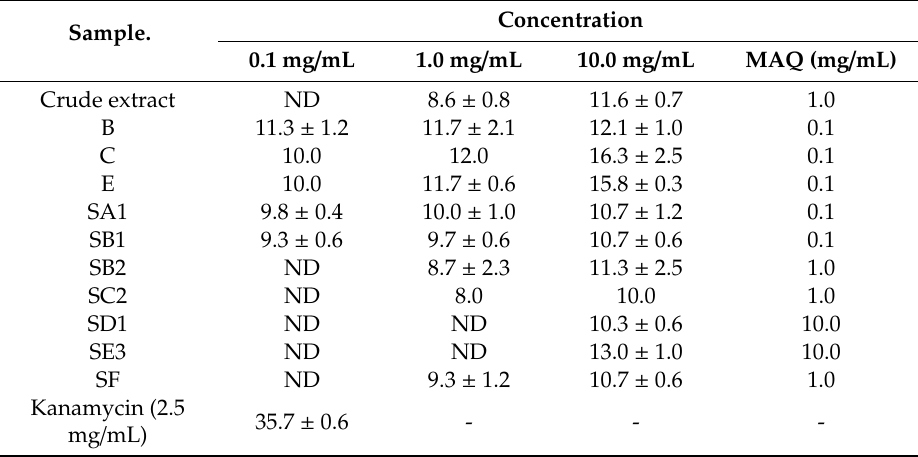
Table 3. Mean diameter of inhibition (mm ± SD) and minimum active quantity (MAQ) values (mg/mL) of Spathodea campanulata crude plant extract, active fractions and sub-fractions against Helicobacter pylori. Sample.